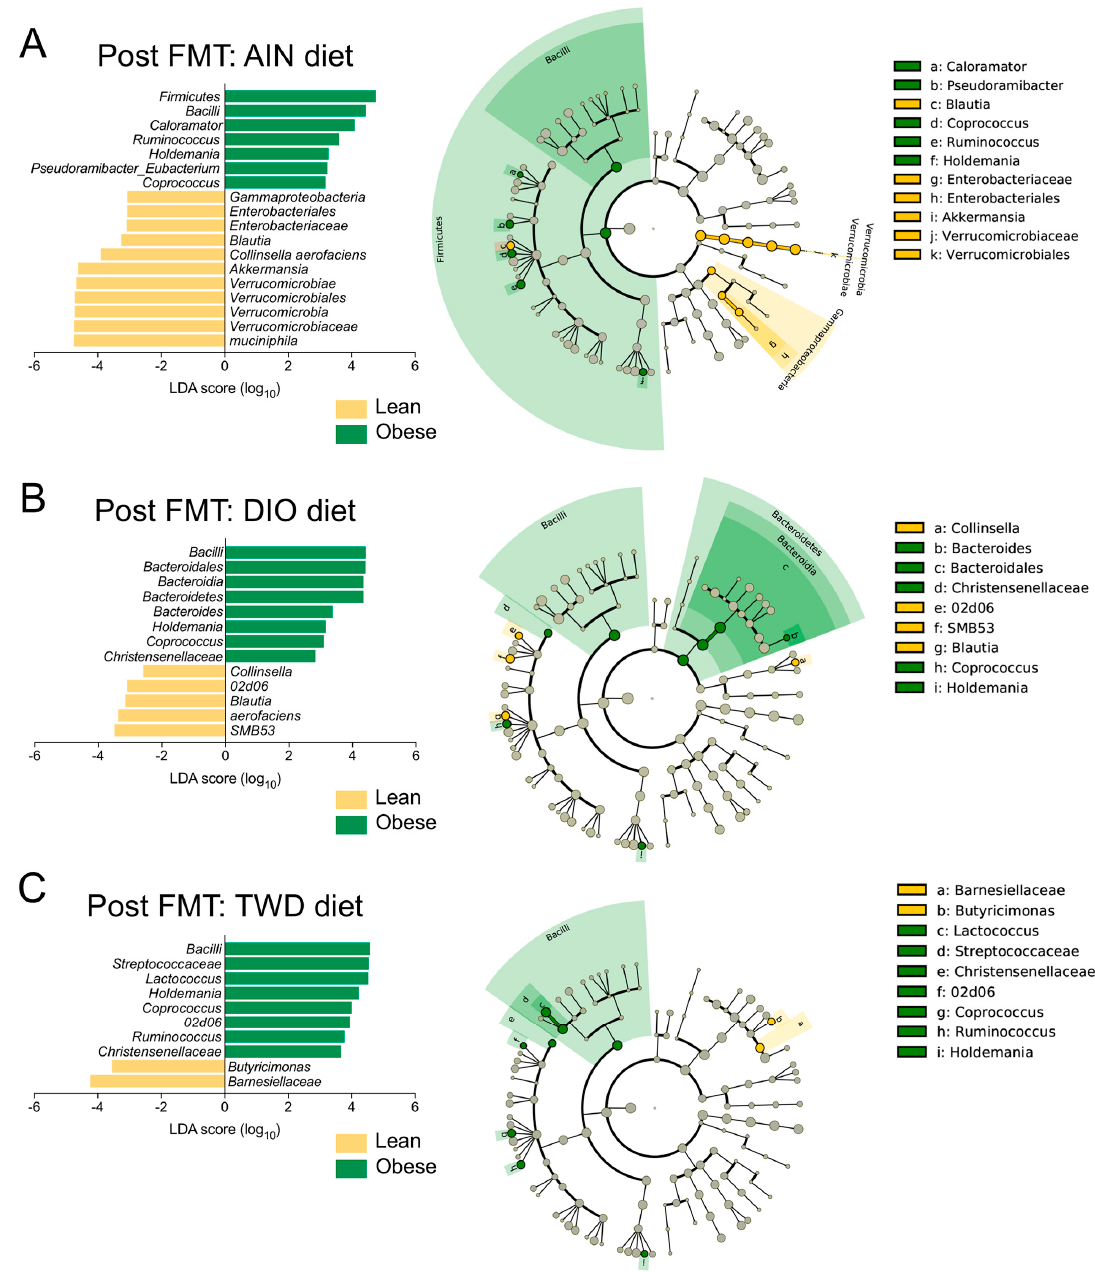
Figure 6. Taxa that discriminated between lean and obese human donors in recipient mice post-fecal transfer. Linear discriminant analysis with effect size (LEfSe) analyses were performed using relative abundance data averaged by human donor at the highest classification level taxonomy available. Data shown are the log 10 linear discriminant analysis (LDA) scores following LEfSe analyses and the hierarch of discriminating taxa visualized as cladograms for class comparisons between lean human donors and obese human donors in recipient mice fed ( A ) AIN, ( B ) DIO, or ( C ) TWD diets. Relative abundance data of selected taxa of interest are shown in Figure S6.